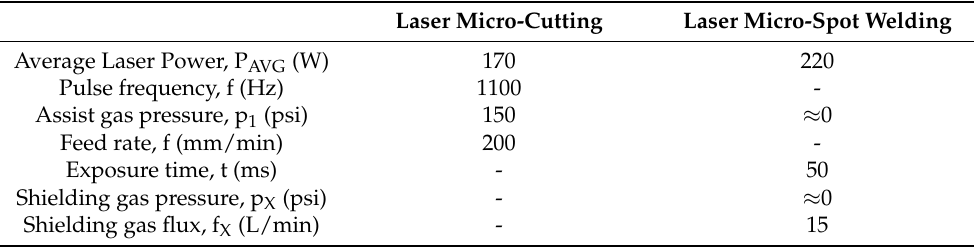
Table 2. Process parameters for the laser micro-cutting and micro-spot welding operations. Laser Micro-Cutting Laser Micro-Spot Welding Average Laser Power, P AVG (W) 170 220